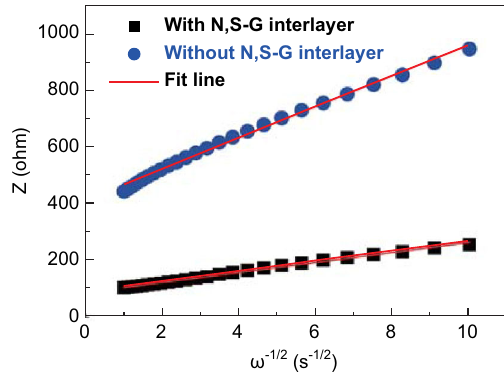
Fig. 8 Z as a function of x - 1/2 in the low-frequency frequencies ( x ) according to the EIS spectrum in Fig. S2b.